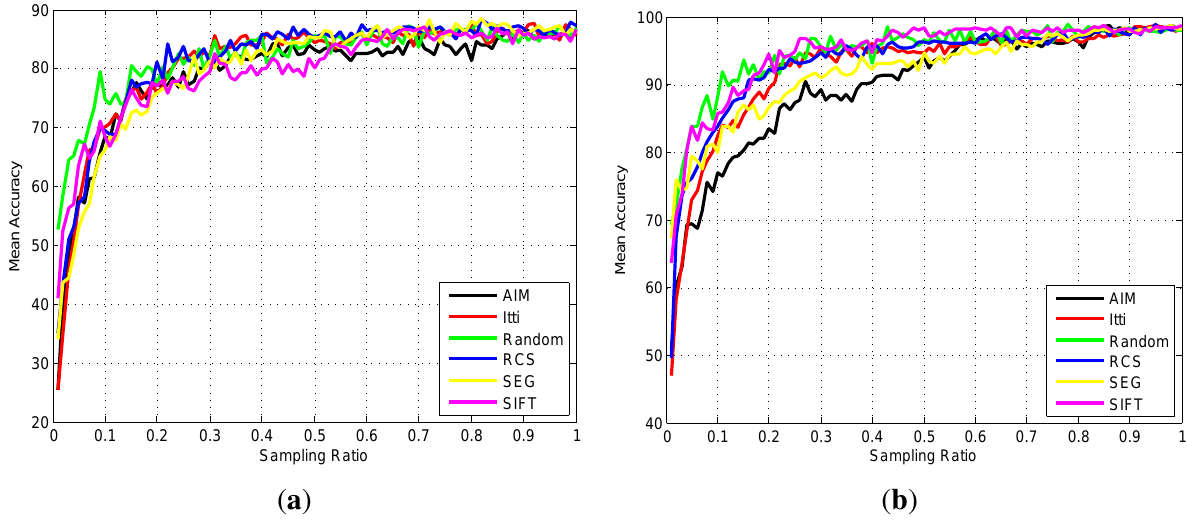
Figure 14. Comparisons of the classification accuracy using different sampling methods on river ( a ) and beach ( b ).